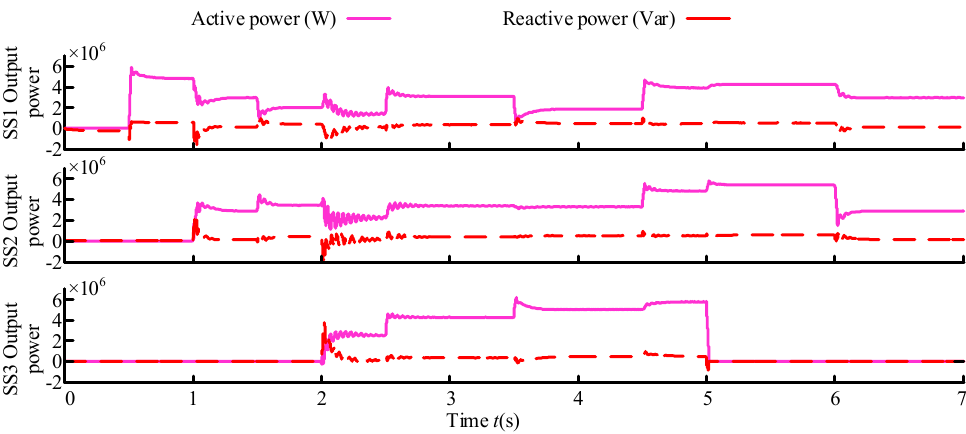
Figure 18. The output active and reactive power of three traction substations.